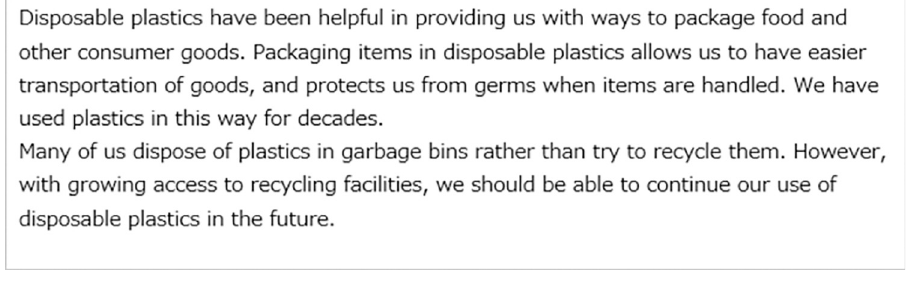
Fig 3. Message presented to the control